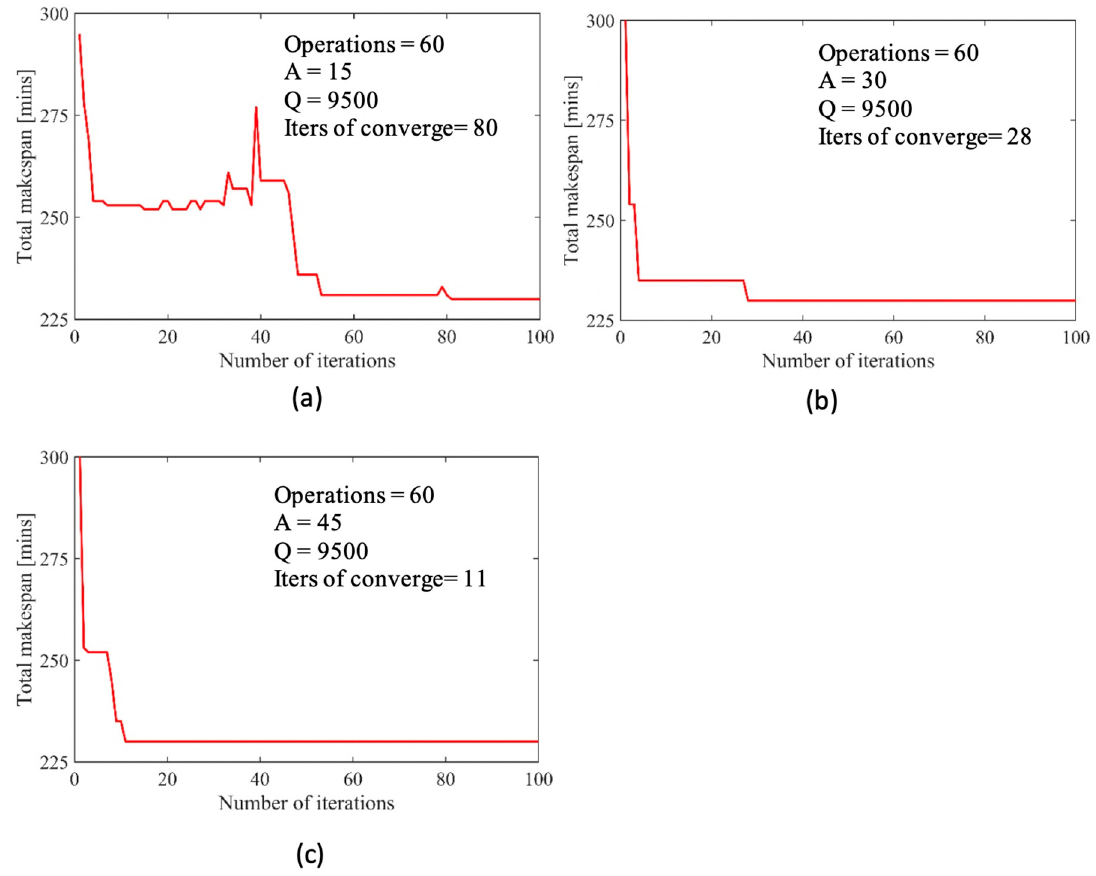
Figure 6. Tuning Number of Ants parameter, A , for a use-case of 60 operations and fixed value of Q = 9500: ( a ) A = 15, ( b ) A = 30 and ( c ) A =